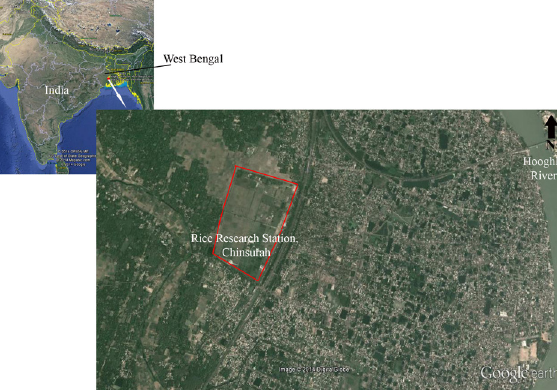
Figure 1. The study area marked with red lines indicates the RRS, Chinsurah. The white boxes are houses and the two curved lines are railway tracks. Inset - Base of the white arrow indicating location of the study area in India. (Maps downloaded from www.googleearth.